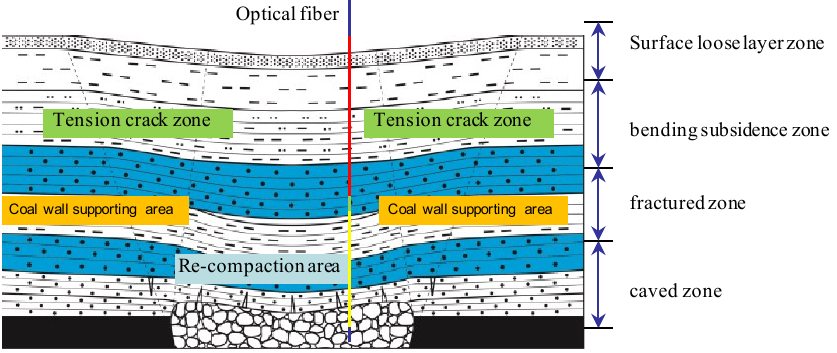
Figure 3. Vertical zoning division of overlying strata caused by mining.